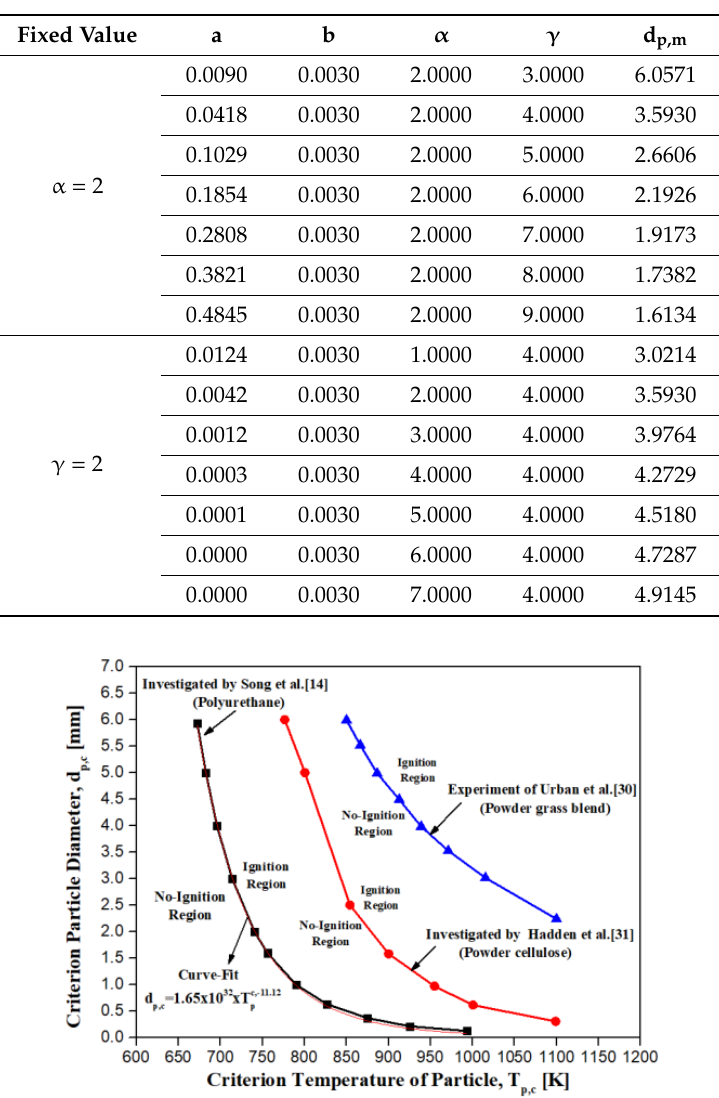
Figure 4. The Nusselt number and heat transfer coefficient with the particle diameter and temperature. 2.5. The Order of Magnitude for Particle and Base Metal The governing equation of Equation (6) cannot be derived analytically due to the radiation term of particle as denoted in Equation (14). To predict the particle temperature with simple equation, the quantities of heat amount are compared with the method of the order of magnitude for the base metal and particle diameter, respectively [32]. Since the base metal can be welded when the melting temperature reaches about ~2327 K while the particle temperature can ignite the flammable materials more than ~750 K as referred to in [14]. The interest region of temperature can divide into ~750 K for particle and ~2327 K for base metal. Figure 5 shows the comparative results of the radiative and the convective heat transfer for one particle at d p,m = 3 mm and u p,m = 10 m/s. Thus, the heat transfer coefficient, h can be obtained from the Reynolds number(